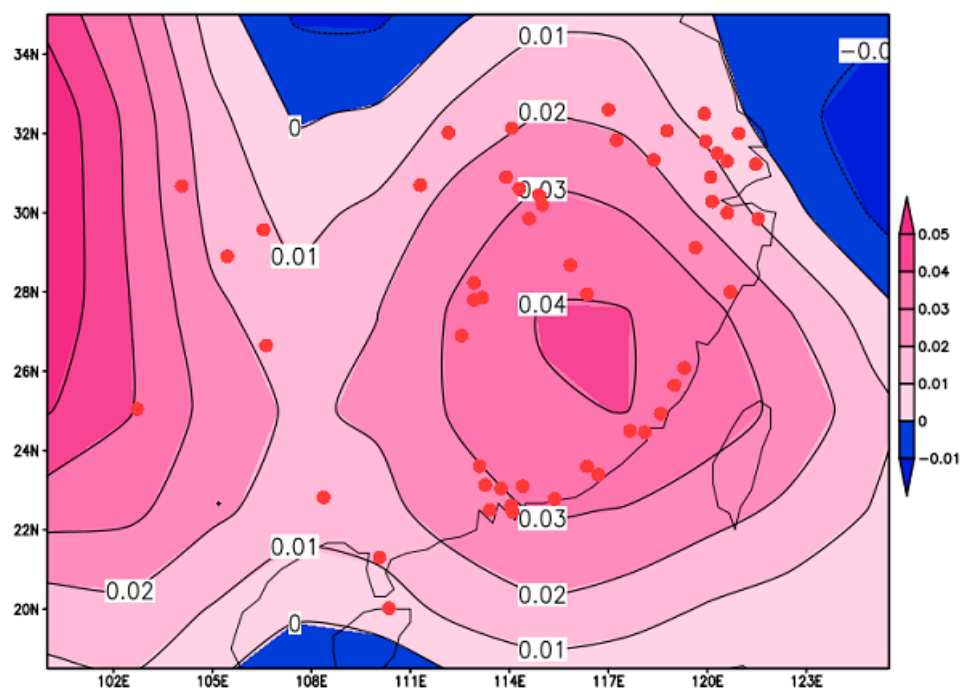
Figure 6. A contour plot of the 17-year (1998–2014), warm-season (May–September) trend of 1000–925 hPa average temperature(°C·year − 1 ).